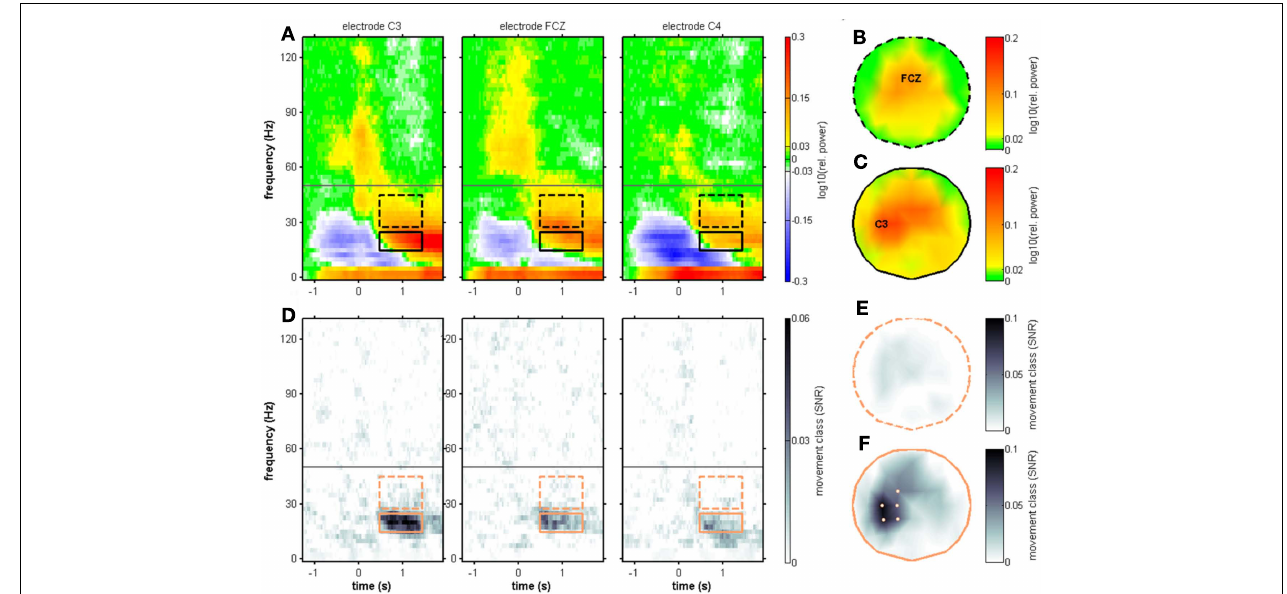
position C3. (D) Median SNR of movement class tuning across subjects. A clear SNR increase was found, confirming the individual results in Figure 5 . (E) Scalp topography of the SNR of the MER2b component. There were no significantly tuned electrode sites ( P < 0.01, FDR-corrected for testing at multiple electrode positions). (F) Scalp topography of the SNR of the MER2a component.The electrode positions FC1, C1, C3, CP1, and CP3 above left sensorimotor areas contralateral to the side of movement where the individual results were significant in at least five of the eight subjects ( P < 0.01, FDR-corrected) are highlighted.